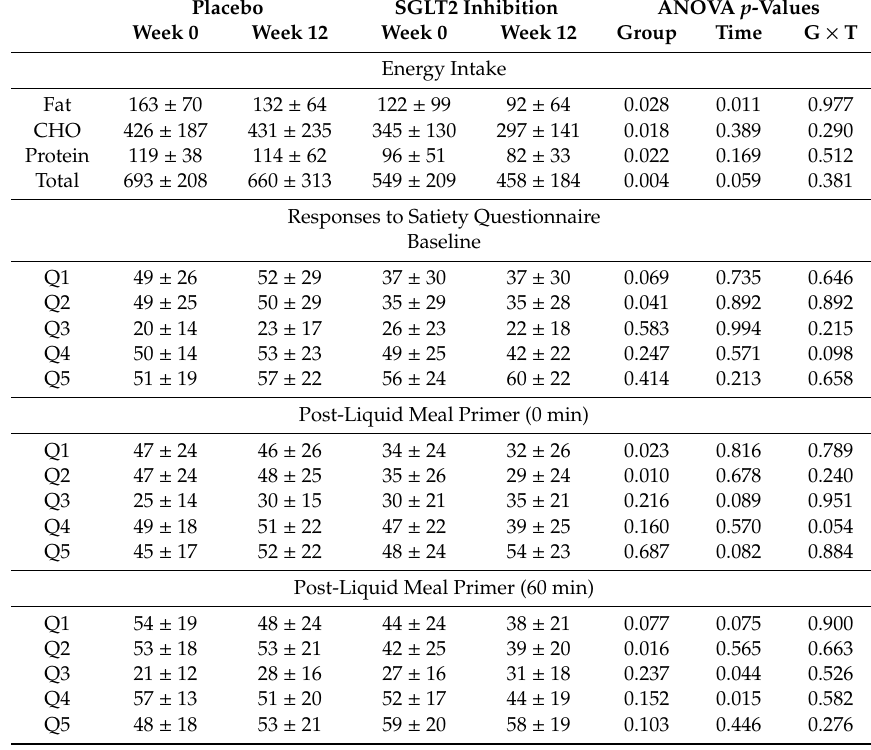
Table 5. Energy intake at breakfast bu ff et and responses to satiety questionnaire prior to and following 12 weeks of dietary counselling for weight loss supplemented with placebo or SGLT2